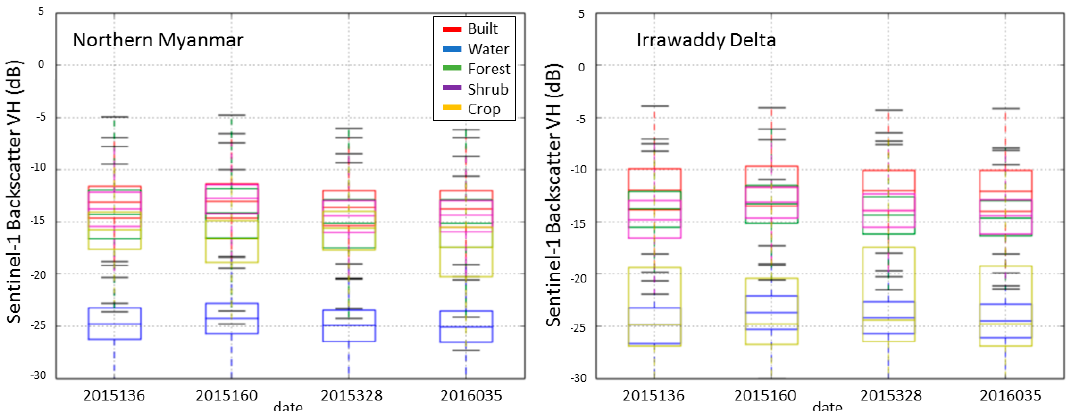
Figure 7. Sentinel-1 Vertical transmit Horizontal receive dB box and whisker plots for two training regions highlighting differences in irrigated rice response.